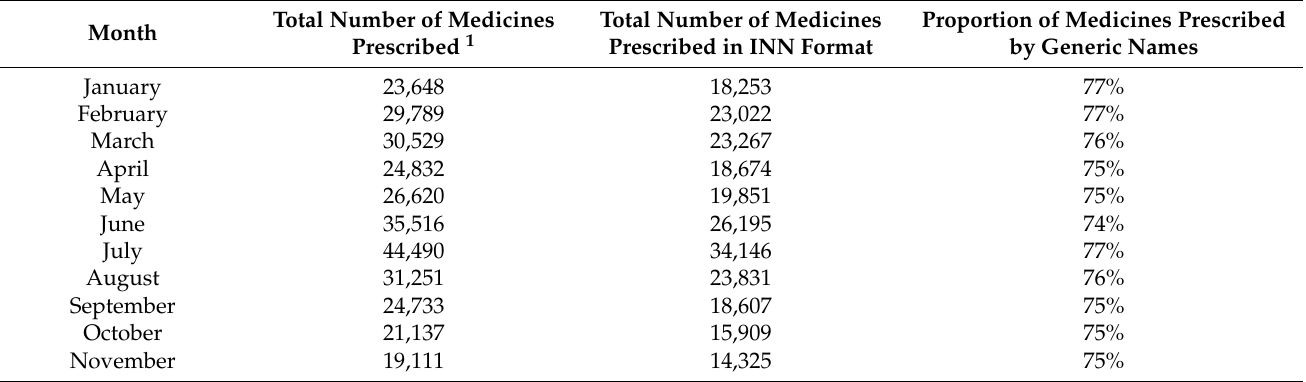
Table 3. Number and proportion of medicines prescribed in the INN format among outpatients of University Hospital, KNUST in